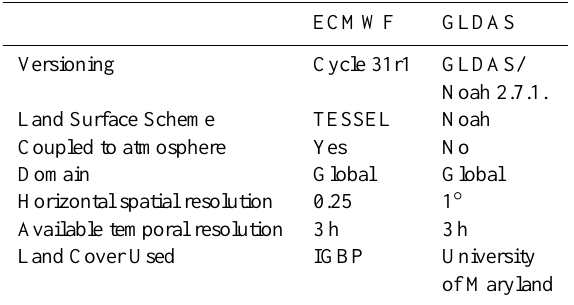
Table 5. Spatial correlation between the mean 1 %ET and the mean of (1) 1 % LAI/ r s min , (2) 1 CVH and (3) 1 % S ↓ for North and South Africa (see